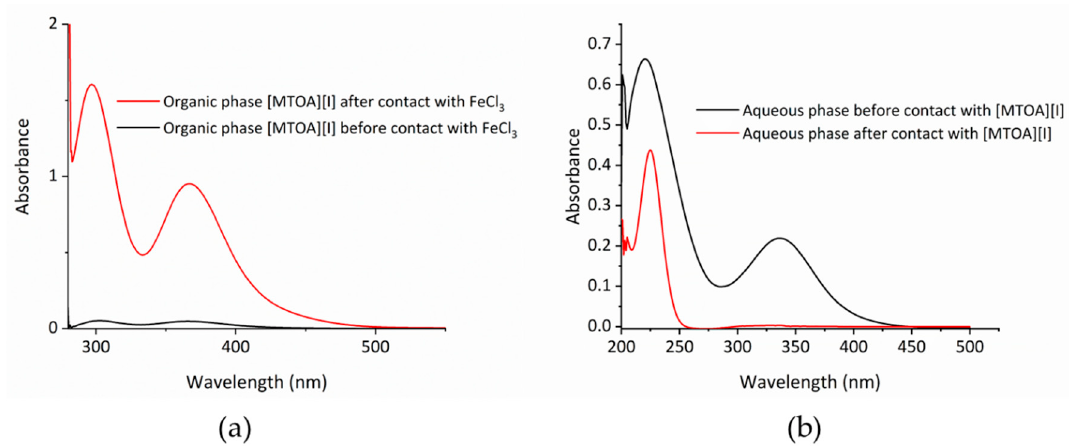
Figure 4. UV-Vis spectra. ( a ) Toluene solutions of [MTOA][I] before (black) and after (red) contact with FeCl 3 . Each solution diluted 500 × in toluene. ( b ) The 2 M HCl solutions of FeCl 3 before (black) and after (red) contact with 0.1 M [MTOA][I] in toluene. Each solution diluted 100 × in 2 M HCl.